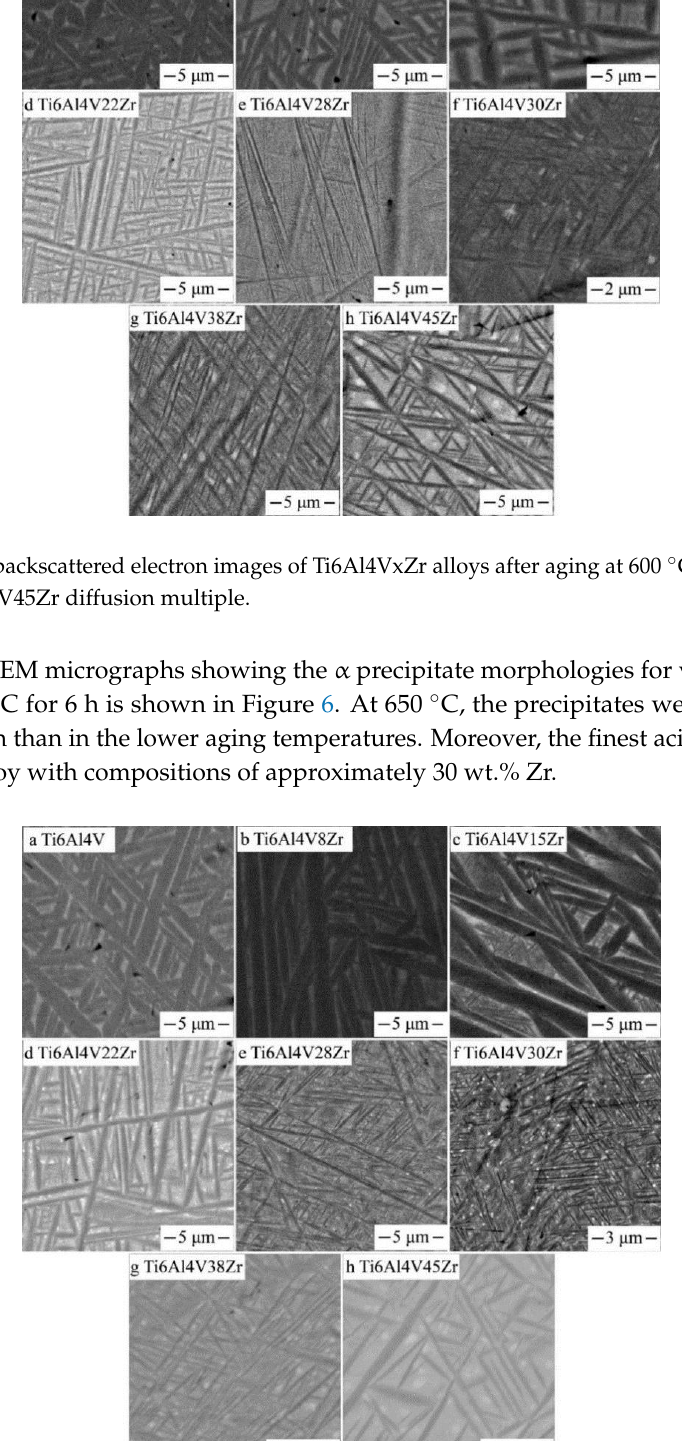
Figure 6. SEM, backscattered electron images of Ti6Al4VxZr alloys after aging at 650 °C taken from the Ti6Al4V–Ti6Al4V45Zr diffusion multiple.